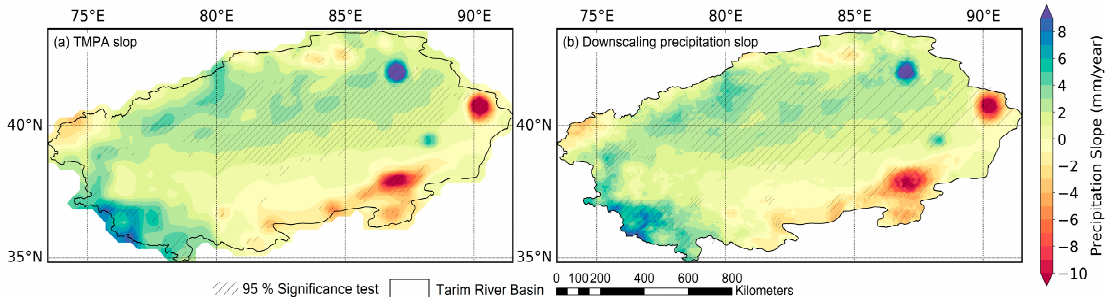
Figure 10. The precipitation slope from 2001 to 2017. ( a ) Precipitation at the low resolution of 0.25 ◦ ; ( b ) precipitation at the low resolution of 1 km.